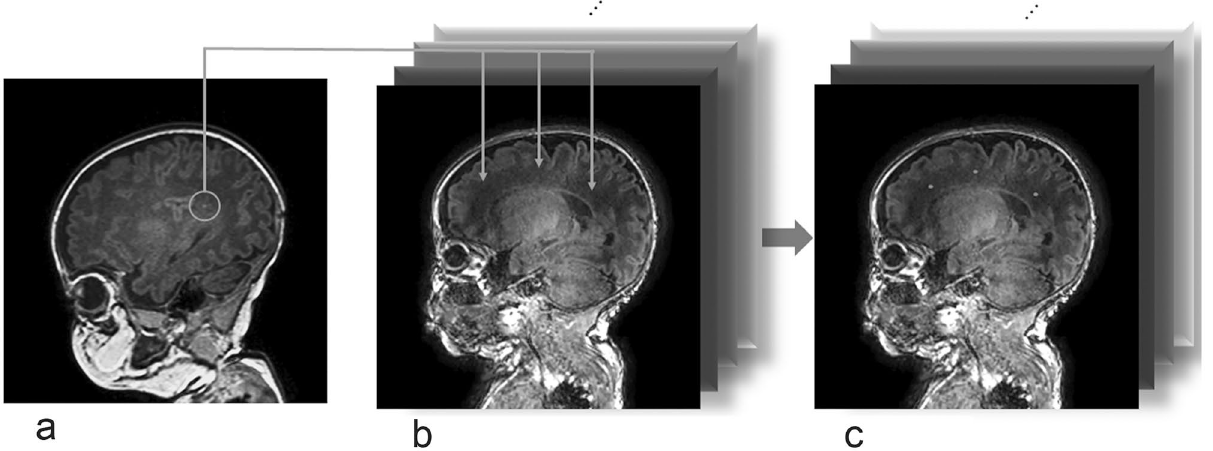
Figure 1. A scheme of a process to create composite images of punctate white matter lesions (PWMLs) for deep learning: PWMLs in an infant ( a ) are extracted, copied, and pasted onto T1-weighted images of infants without abnormal findings ( b ). Repeating this process creates many composite PWMLs images for the training of deep learning ( c